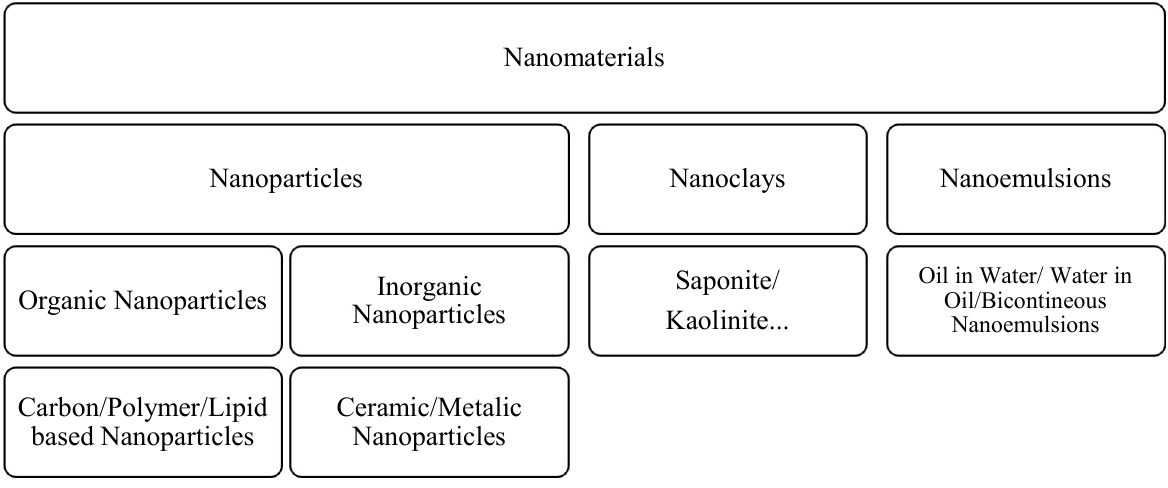
Figure 1. Types of Nanomaterials.